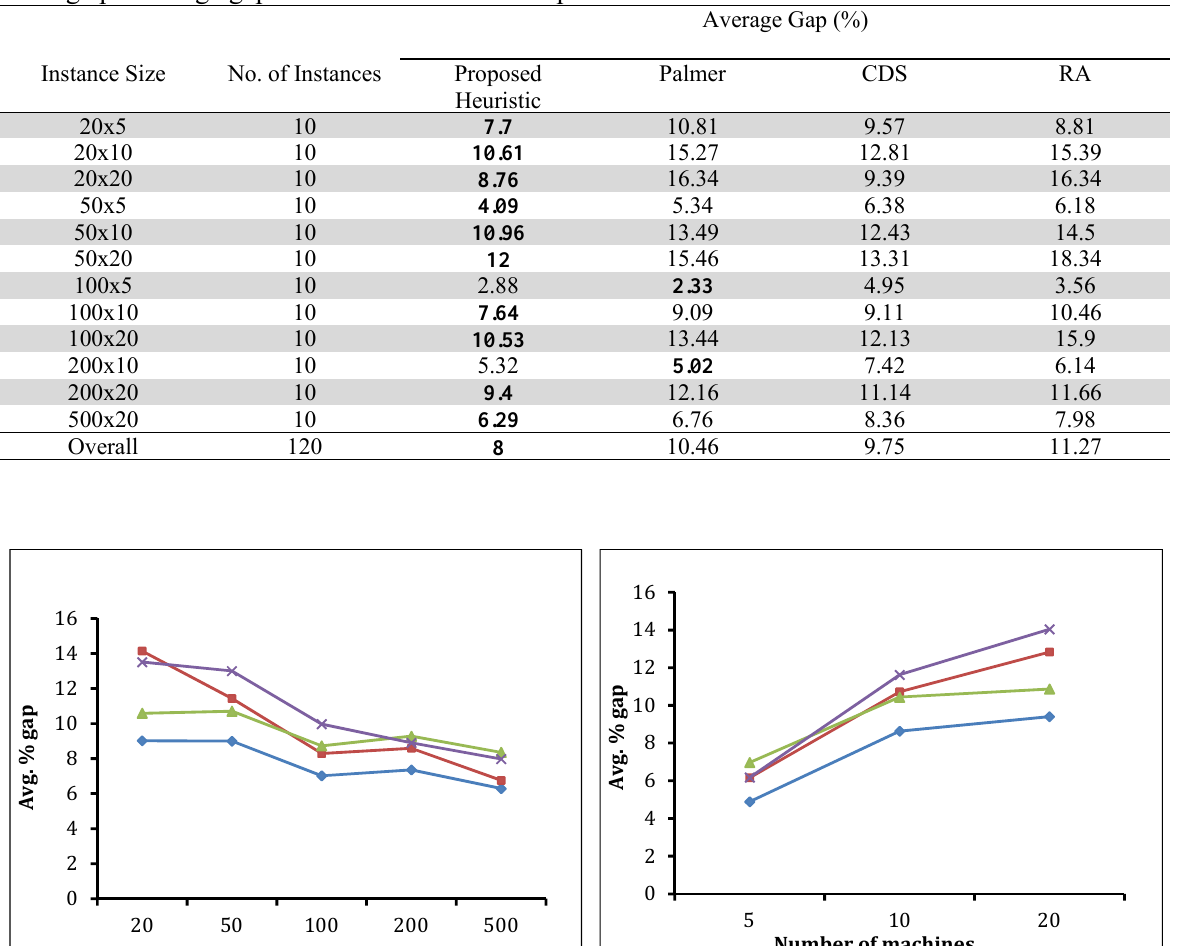
Average percentage gaps for Taillard benchmark problems.